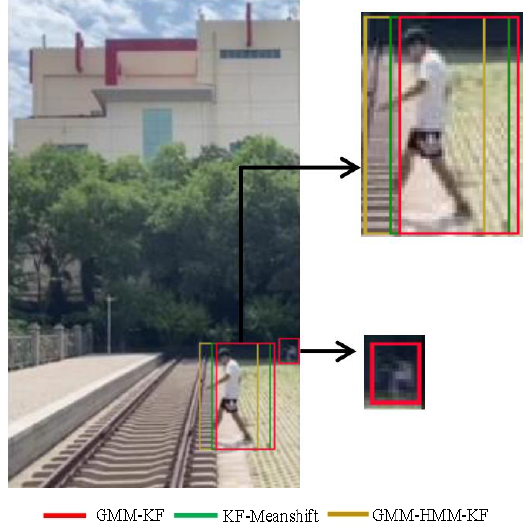
Fig. 13. The original image of the 193 th frame of video